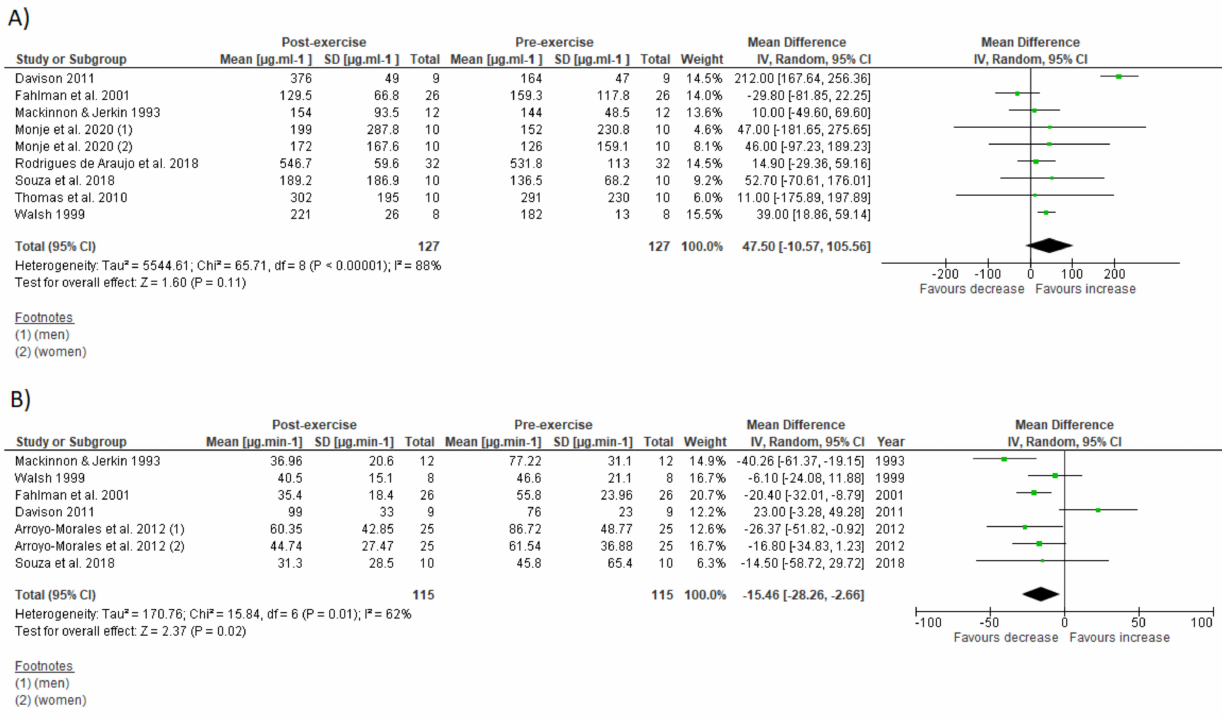
Figure 4. Forest plot of the acute effects of interval training on absolute immunoglobulin A concentration ( A ) and immunoglobulin secretory rate ( B ). SD standard deviation, CI confidence interval, IV random effects. The green squares represent the mean difference for each dataset. The black diamonds represent the estimated overall